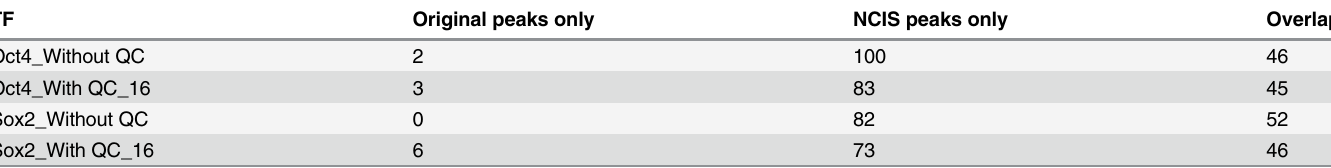
Table 2. Comparison of peaks found by MACS+NCIS used in our study and the original peaks published with Oct4 and Sox2 ChIP-Seq datasets. TF Original peaks only NCIS peaks only Overlap Oct4_Without QC 2 100 46 3 83 45 0 82 52 Sox2_With QC_16 6 73 46 With QC_16 means before mapping to the genome, low quality reads and reads having a length of less than 16 nt are removed using quality control tool FASTX-Toolkit [45].